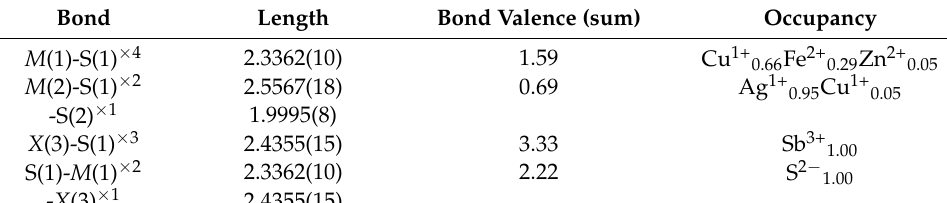
Table 4. Bond lengths and bond valence sum ( v.u .) of atoms in kenoargentotetrahedrite-(Fe).